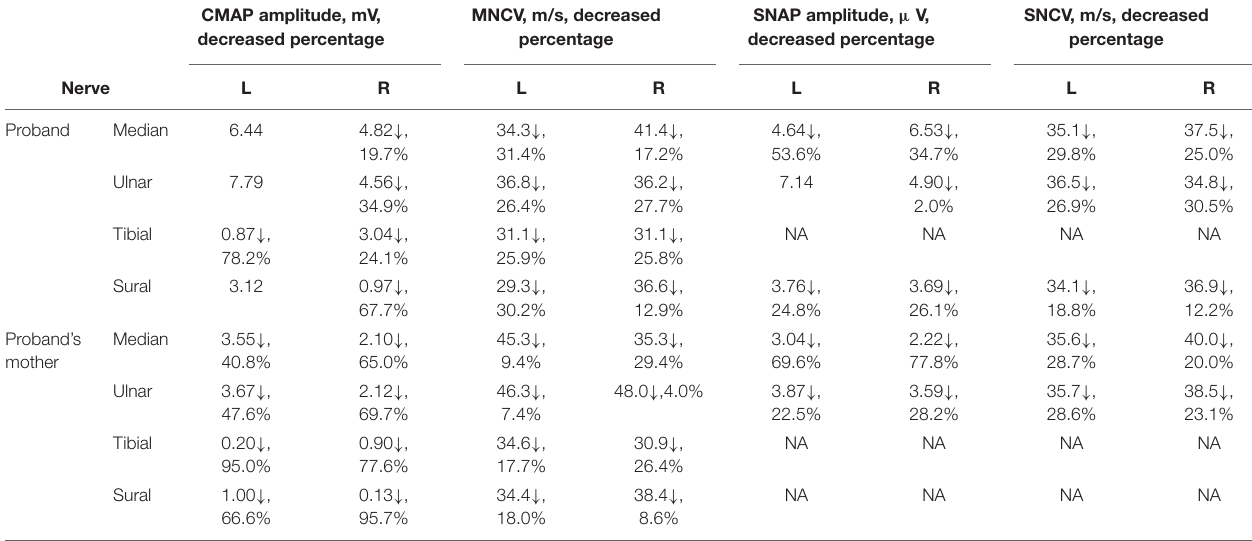
TABLE 1 | Results of nerve conduction velocity studies in our